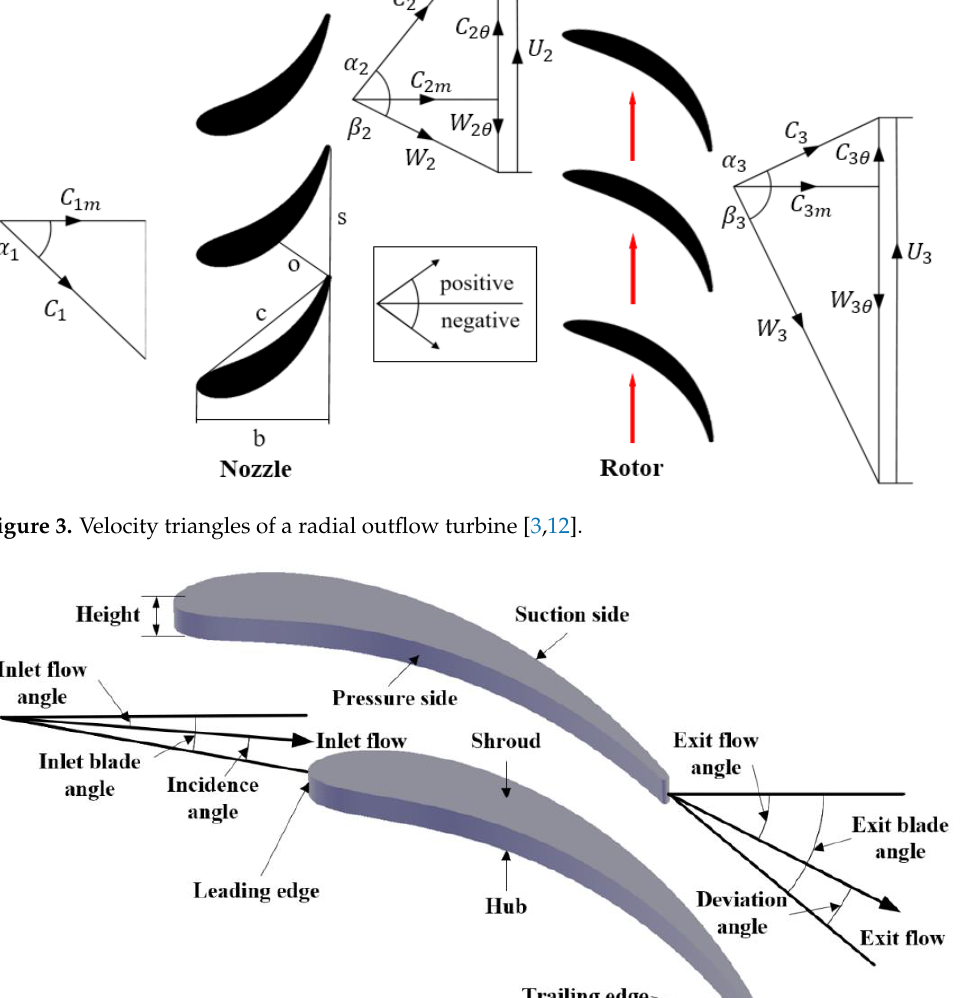
Figure 5. H–S diagram of a two-stage radial outflow turbine. In Figure 5, the total-total efficiency ( 𝜂 𝑡𝑡 (𝑖) ) and total-static efficiency ( 𝜂 𝑡𝑠 (𝑖) ) of the 𝑖 th stage can be expressed by Equations (3) and (4), respectively [27]. In the two-stage case, the total-total efficiency ( 𝜂 𝑡𝑡 ) and total-static efficiency ( 𝜂 𝑡𝑠 ) of the overall stage are as shown in Equations (5) and (6), respectively [28]. In addition, the total enthalpy ( ℎ 0 ) and static enthalpy ( ℎ ) at a specific point have the same relationship as in Equation (7): 𝜂 𝑡𝑡 (𝑖) = (ℎ 01 (𝑖) − ℎ 03 (𝑖))/(ℎ 01 (𝑖) − ℎ 03𝑠 (𝑖))